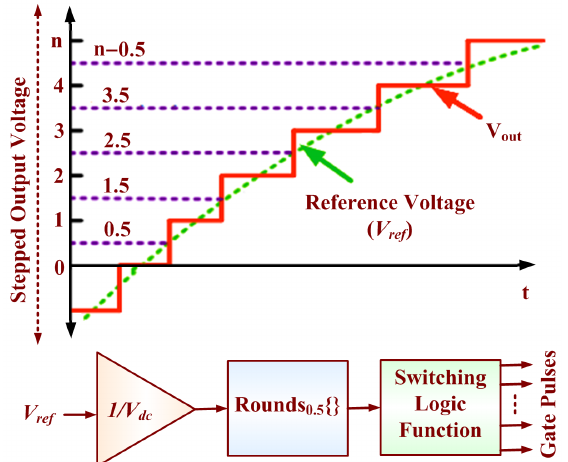
Figure 10. Nearest Level Modulation Technique ( a ) Stepped voltage waveform and ( b ) schematic block diagram.